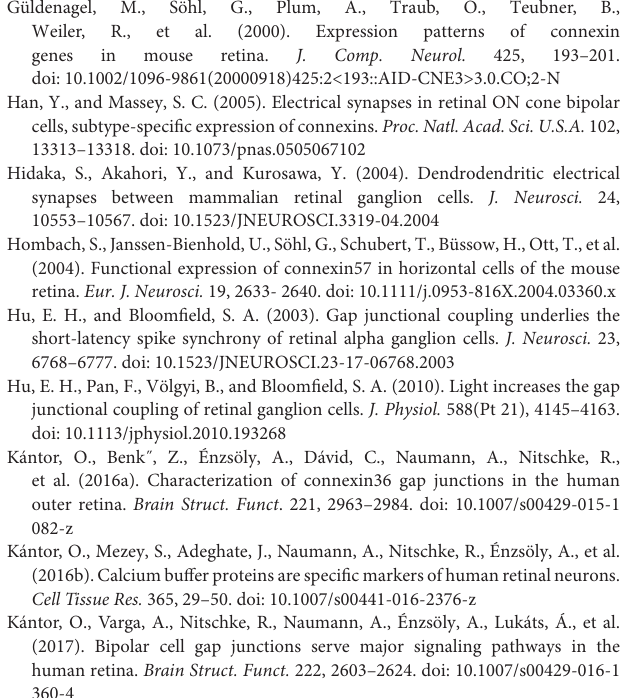
Supplemental Figure 1 | Number (top) and plaque density (bottom) differences between P-like and non-P-like hRGCs. Statistical analyses reveal that P-like cells display considerably less Cx36 plaque colocalizations than non-P-like cells (Wilcoxon signed-rank test P < 0.05). The somata and dendritic arbors of representative P-like and non-P-like hRGCs are shown above the corresponding bars. Scale bars: 25 µ m. Supplemental Figure 2 | Number (A) , plaque length density (B) and plaque surface density (C) histograms for all examined hRGCs display non-homogenously increasing values with several plateaus. This indicates that cells in these analyses form subgroups. Supplemental Figure 3 | (A,B) Terminal segment length density / total length density (A) as well as terminal segment volume density/total segment volume density (B) ratios are presented. Should a cell have value > 1, that means plaques of that certain cell are most frequent in their terminal segments. Both charts display that for most cells (length density: 42 out of 47 cells, volume density: 34 out of 47) the ratios are > 1. Supplemental Figure 4 | (A–F) Images display multiple immunolabels of PV, CaR, CaB, and Cx36. Colocalizing Cx36 plaques can be detected on CaR + (A,B) , on CaB (C,D) , on PV (E) and on CaB/PV dually stained (F) hRGC + + dendritic processes. It has been shown that PV/CaB dual labeled hRGCs display OFF parasol cell morphology ( Kántor et al., 2016b). Scale bars: 20 µ m. Supplemental Table 1 | Table shows measured parameters for all examined hRGCs of this study (left column), the total dendritic lengths (second column, number of all colocalizing Cx36 plaques (third column), the number of Cx36 plaques colocalizing with terminal dendrites, number of all plaque intervals for each cell (fourth column) and the number of plaque intervals < 5